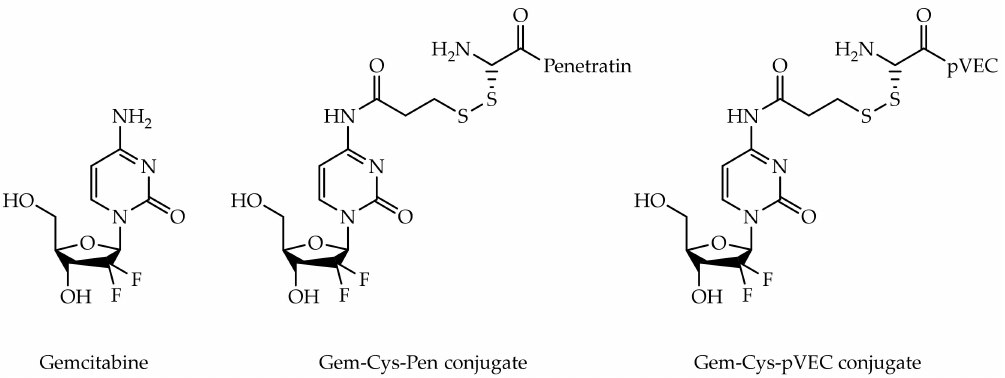
Chemical structures of gemcitabine and gemcitabine-CPP conjugates Gem-Cys-Pen and